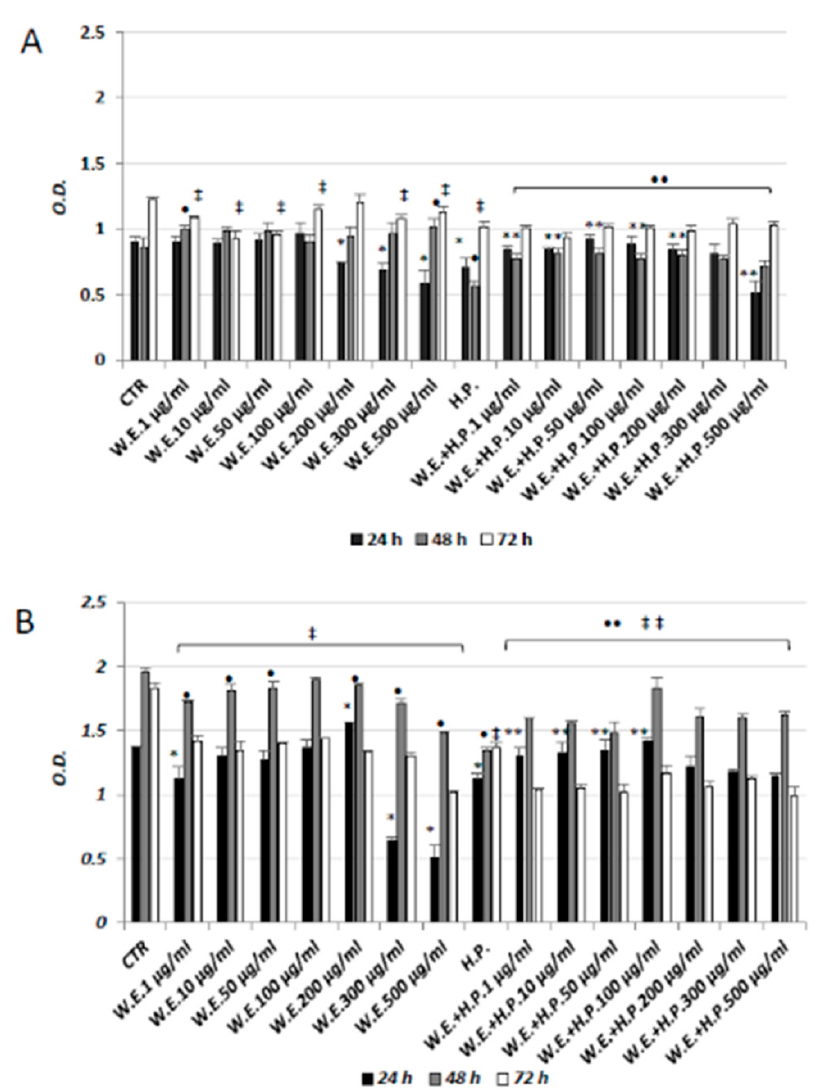
Figure 4. MTT assay in HGFs ( A ) and HaCat cells ( B ) in presence of different concentrations of hemp water extract (W.E.) and/or H 2 O 2 (H.P.). n = 3. * p < 0.05 vs. Ctr 24 h; • p < 0.05 vs. Ctr 48 h; ‡ p < 0.05 vs. Ctr 72 h; ** p < 0.05 vs. H.P. 24 h; •• p < 0.05 vs. H.P. 48 h; ‡‡ p < 0.05 vs. H.P. 72 h.